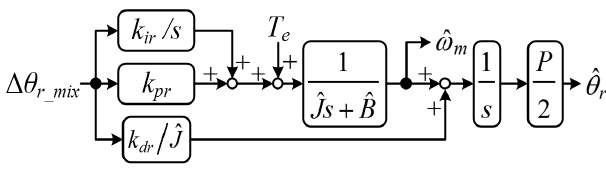
Figure 3. Rotor position and speed estimator.